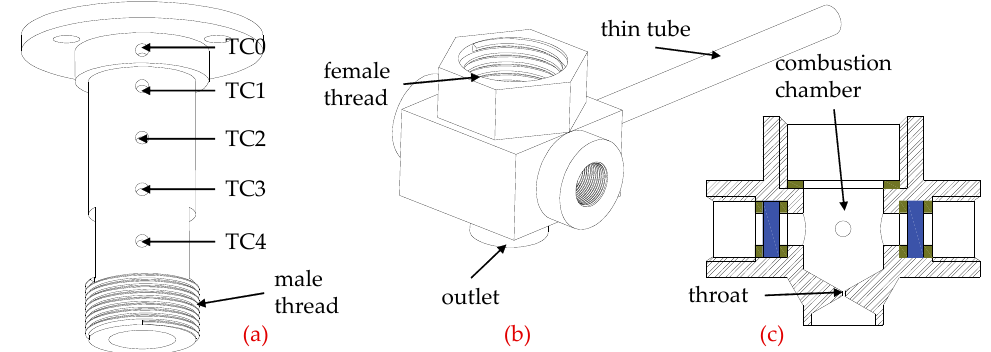
Figure 2. The catalytic and the convergent nozzle: ( a ) catalytic bed; ( b ) convergent nozzle; ( c ) section view of the convergent nozzle.